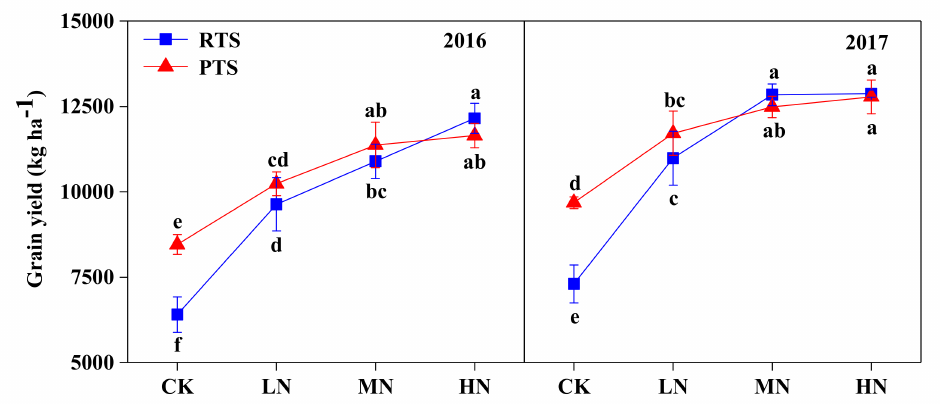
Figure 7. Response of grain yield to tillage with straw incorporation and N treatment in 2016–2017. RTS, rotary tillage with straw incorporation; PTS, plow tillage with straw incorporation. CK, LN, MN, and HN indicate 0, 112, 187, and 262 kg N ha − 1 applied, respectively. Di ff erent lowercase letters indicate significant di ff erences for grain yield between tillage with straw incorporation and N treatment for p < 0.05 level,